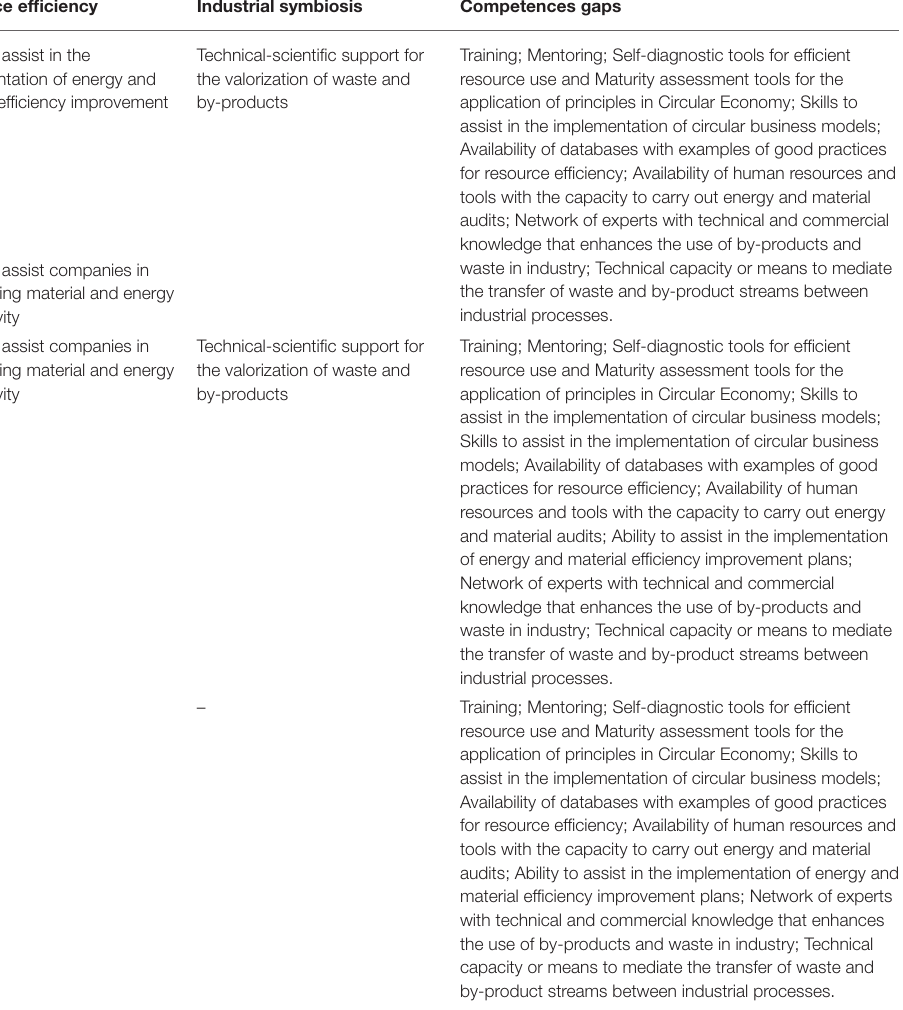
TABLE 2 | Characteristic competences and competence gaps of the three CIT groups. CIT